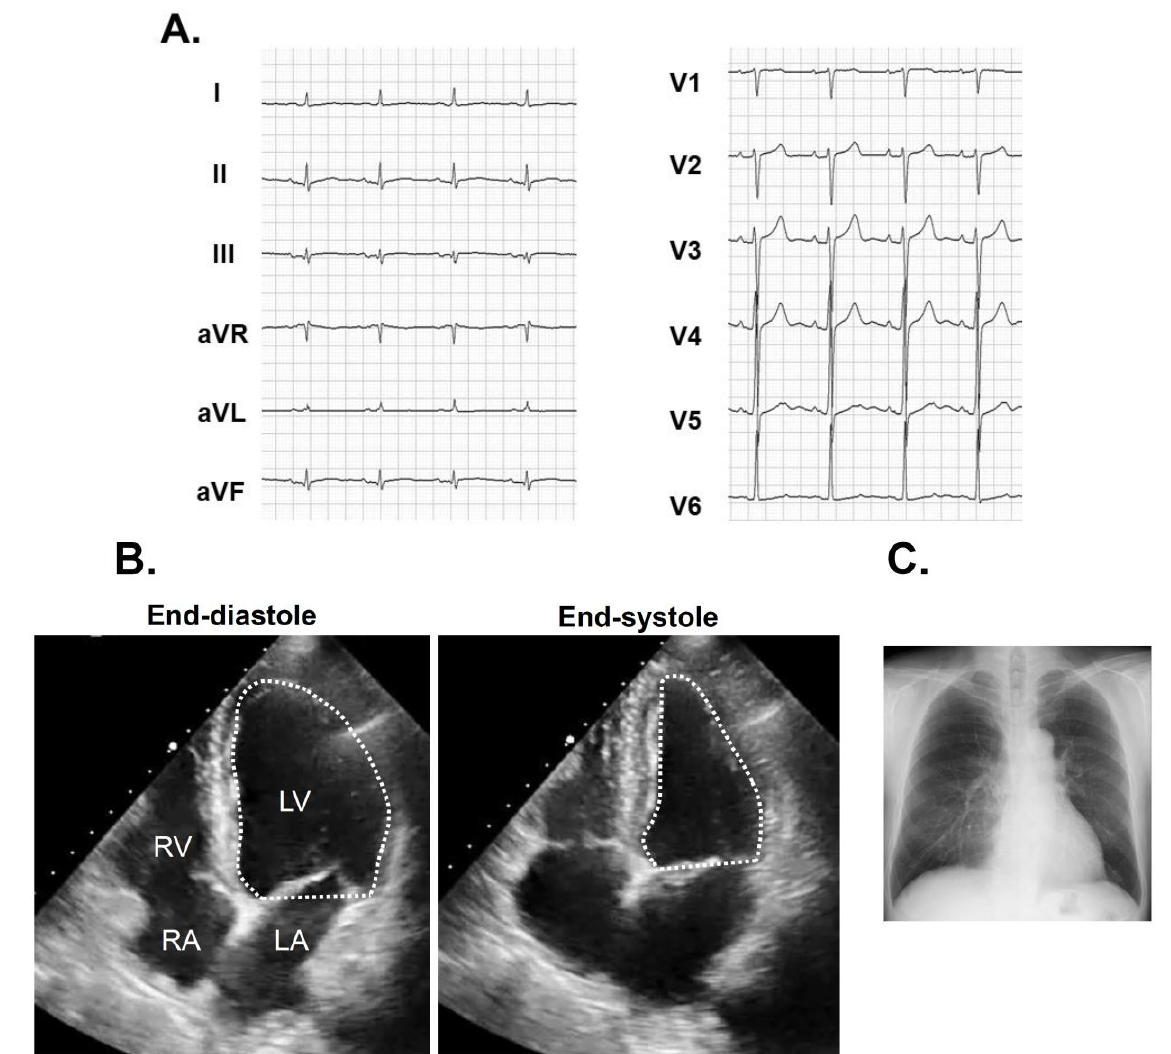
Figure 3. Electrocardiogram at index discharge showing sinus rhythm ( A ). Transthoracic echocardiography showing 65% of left ventricular ejection fraction ( B ) and chest X-ray with 45% of cardiothoracic ratio ( C ) obtained at three months following catheter ablation.